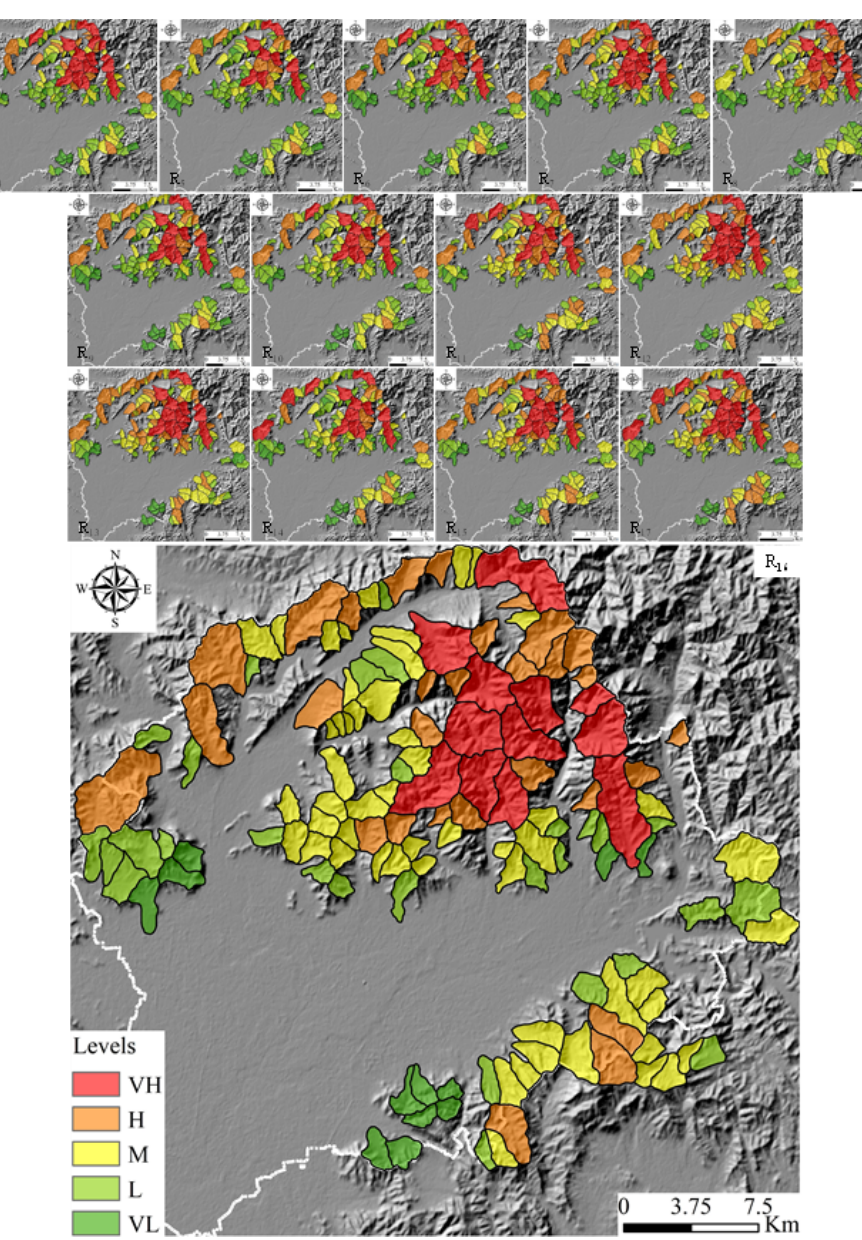
Figure 8. Debris flow susceptibility maps. Note: AUC results of R 1 – R 4 below 0.7 are not shown. VH represents very high susceptibility area, H represents high susceptibility area, M represents moderate susceptibility area, L represents low susceptibility area, and VL represents very low susceptibility